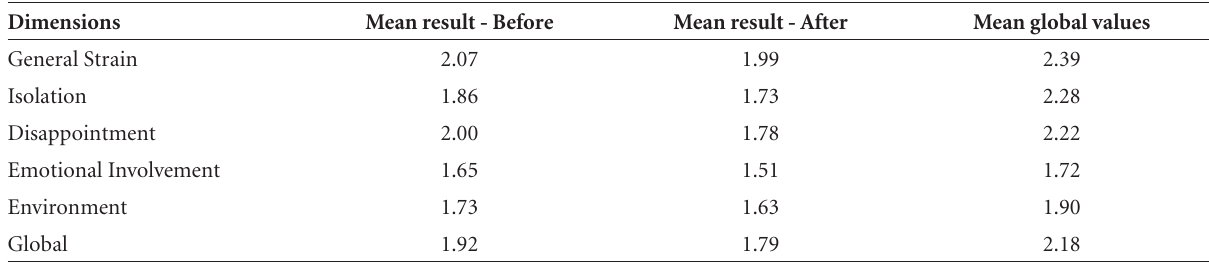
Table 4. Comparison of study results showing mean global values on Caregiver Burden Scale applied in caregivers of patients with Alzheimer’s